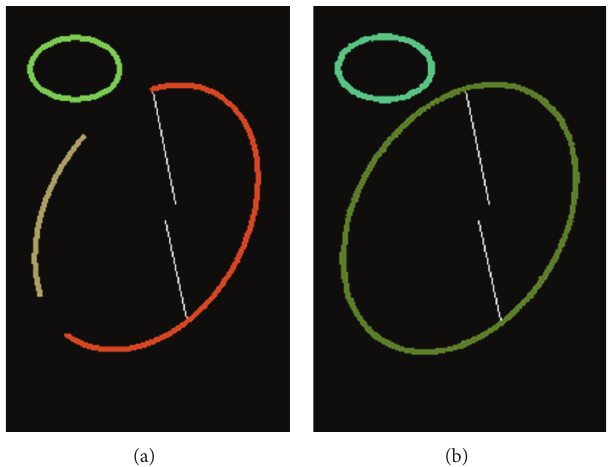
Figure 6: Results of line segment merging and elliptical arc merging. (a) Result of line segment merging. (b) Result of elliptical arc merging.